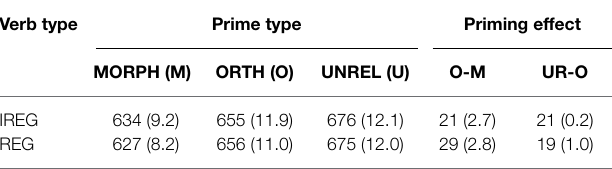
TABLE 4 | Mean response latencies and (error rates) of targets primed by morphological, orthographic, and unrelated primes for Experiment 2. Verb